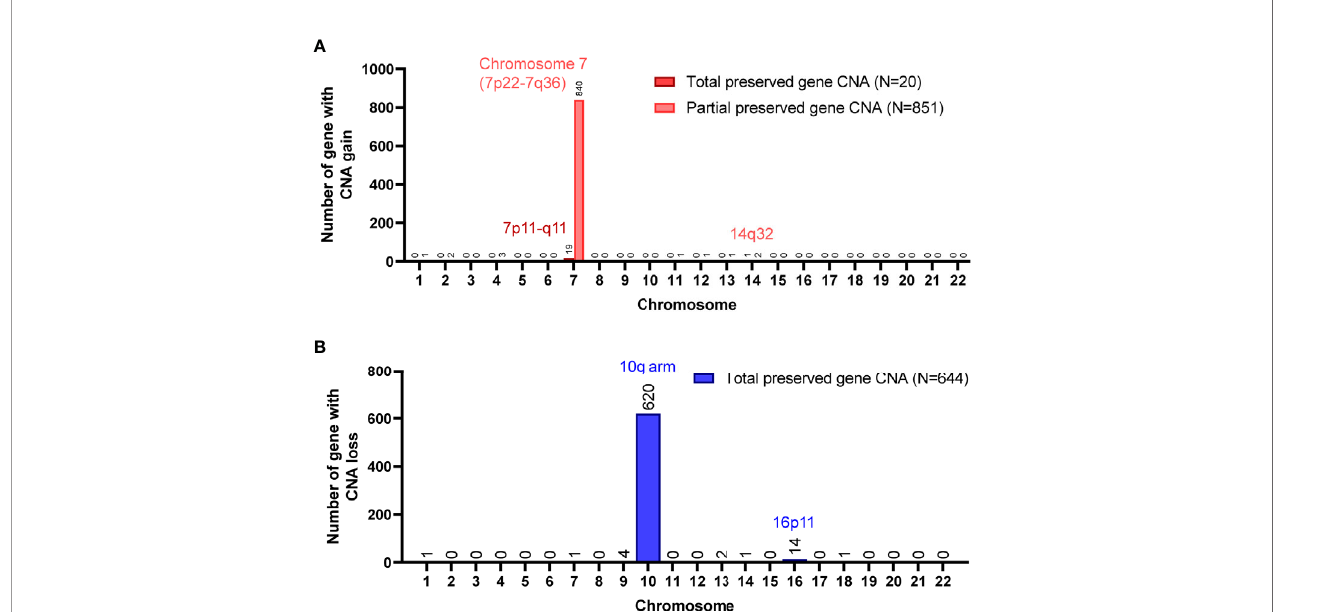
FIGURE 5 | Chromosome distribution of genes with CNA preserved in GBM primary cells. (A) The chromosome distribution of genes with CNA gain preserved in primary cells. (B) The chromosome distribution of genes with CNA loss preserved in primary cells. Total, the targeted gene CNAs in patient specimens were all preserved/lost in their primary cells. Partial, at least 60% of primary cells preserved or lost the targeted gene CNAs.